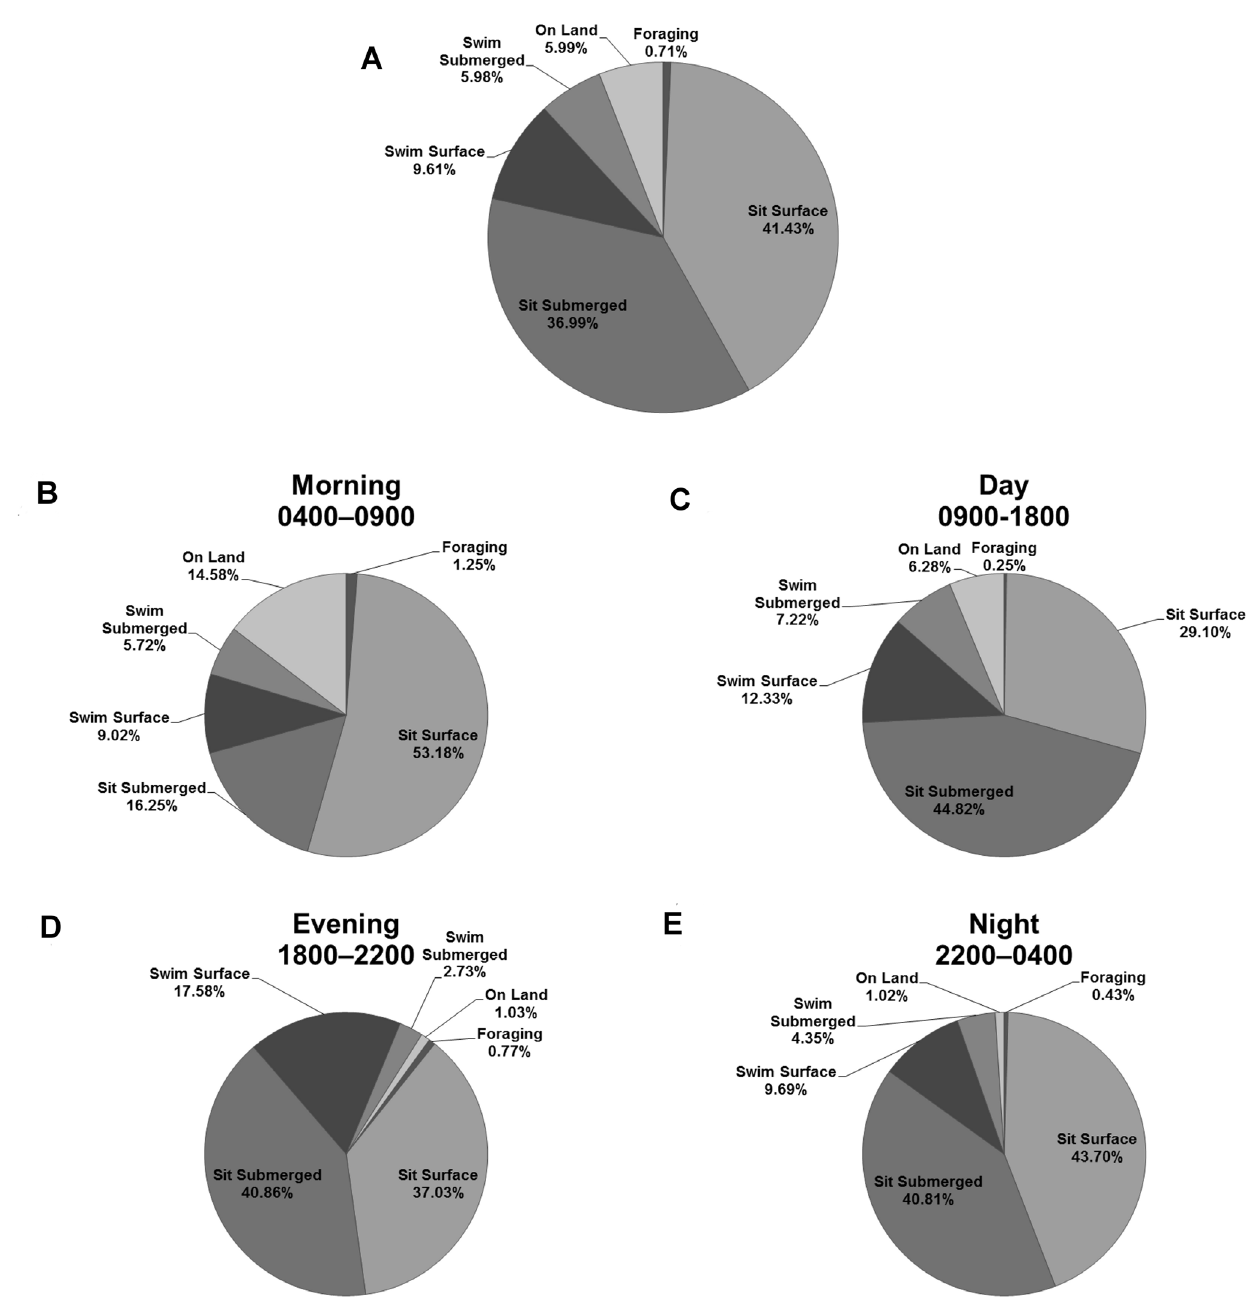
Figure 4. Alligator diel activity. Pie-charts of proportion of alligators spent time performing basic activities during A) all recordings, B) Morning (0400–0900), C) Day (0900–1800), D) Evening (1800–2200), and E) Night (2200–0400). Proportions are calculated as the sum of elapsed time performing an activity divided by the total time of video recordings during each time interval.